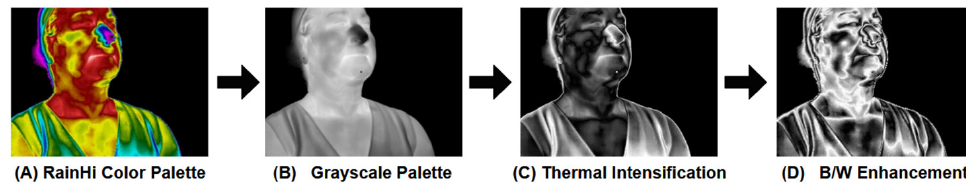
Figure 7. Representation of the image intensification process (step 3).